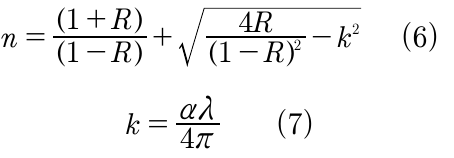
of the wavelength 19 . The refraction indexes and extinction coefficients of the films are calculated by the formulas 16,17 :